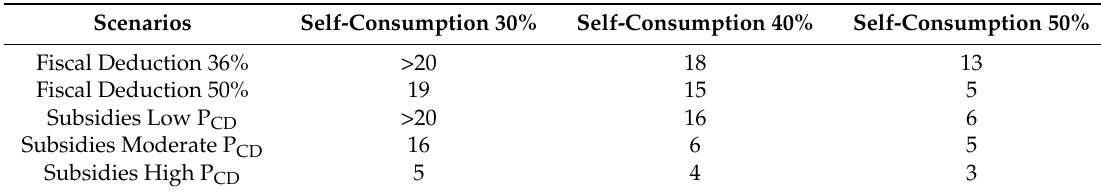
Table 3. DPBT in baseline scenario. Data expressed in